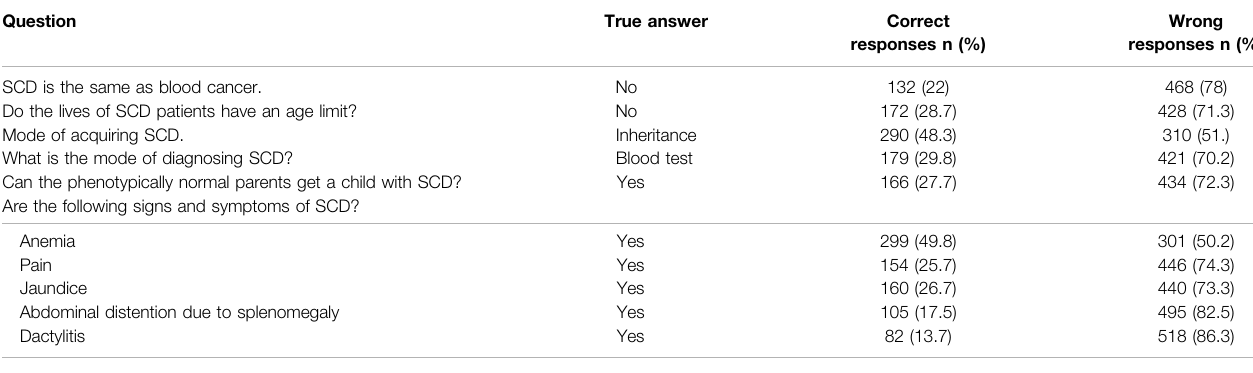
TABLE 3 | Response to questions on knowledge on SCD. Question True answer